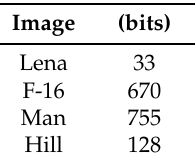
Table 3. Maximum size of images’ L _ map .